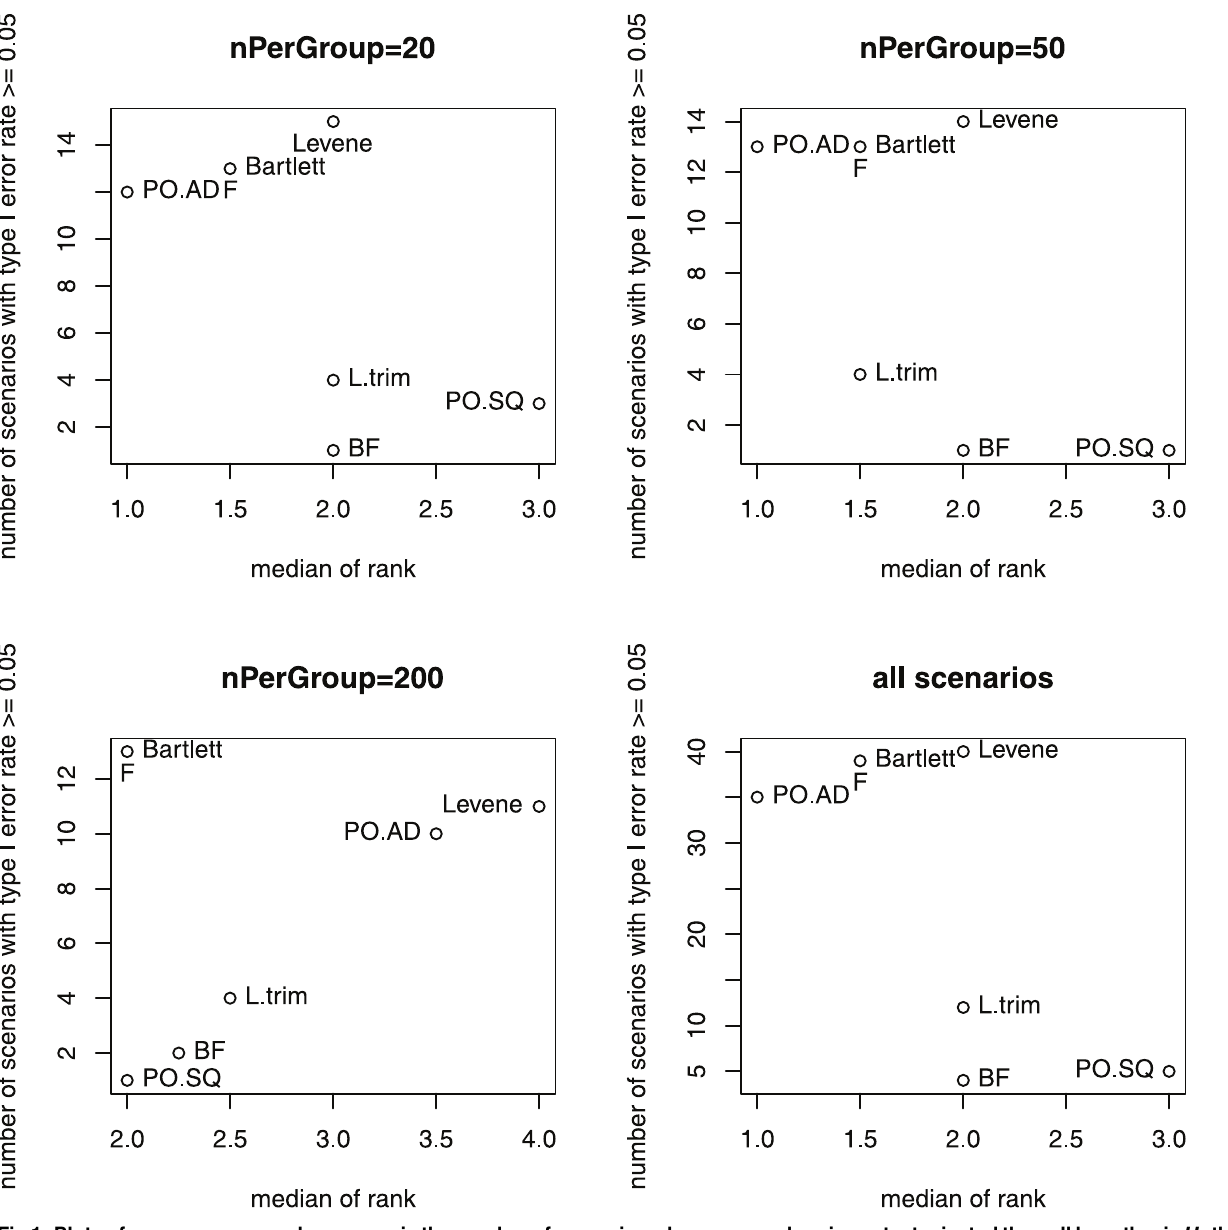
Fig 1. Plots of n reject versus m , where n reject is the number of scenarios where an equal-variance test rejected the null hypothesis H 0 that the type I error rates is (cid:3) 0.05 and m is the median of the ranks of powers. For ranks with ties, average ranks were used. The upper-left, upper-right, bottom-left panels are the plots where n reject and m were obtained based on scenarios with sample size 20, 50, or 200 subjects per group, respectively. The bottom-right panel is the plot where n reject and m were obtained based on all 48